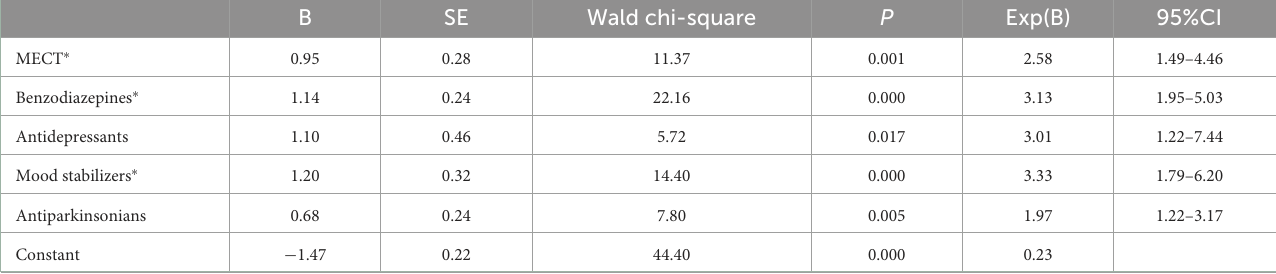
TABLE 3 Multivariate logistic regression analysis of risk factors for HAP in patients with schizophrenia treated with